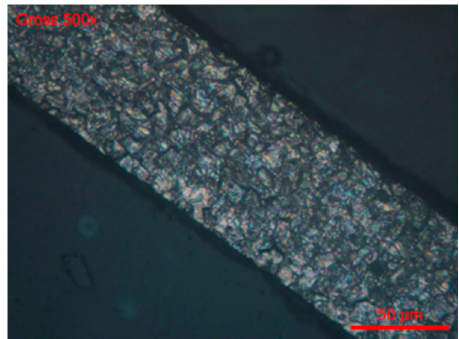
Figure 18. ( a )#Test 1 and ( b ) #Test 2. Grain index (ASTM E112-13) G = 11.